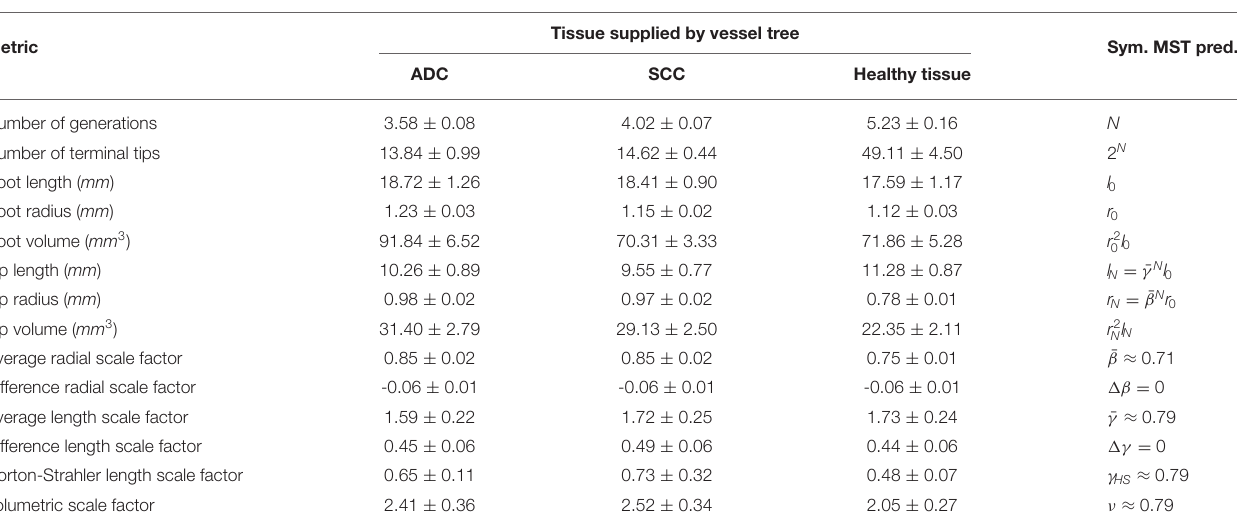
TABLE 2 | Summaries of vessel network